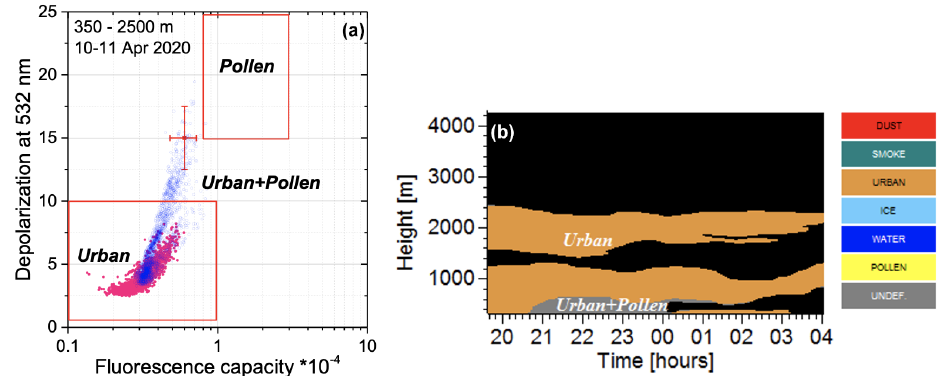
Figure 12. (a) The δ 532 - G F diagram for observations at 350–1500m (blue symbols) and 1500–2500m (pink symbols) height ranges. (b) Spa- tiotemporal distribution of aerosol types on the night of 10–11 April 2020. The gray coloring shows an undefined aerosol type, which is a mixture of urban and pollen for this case. Measurements with β 532 < 0.2Mm − 1 sr − 1 are marked in black.